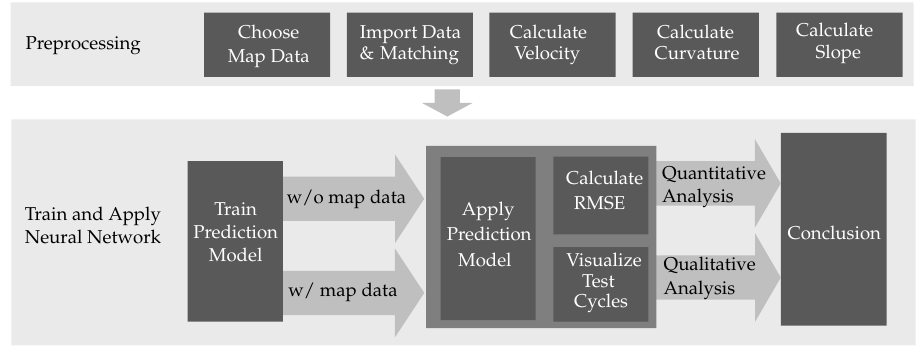
Figure 2. Applied methodology to evaluate both utilization of LSTMs and reveal benefits by use of map data. This also includes several steps of preprocessing.